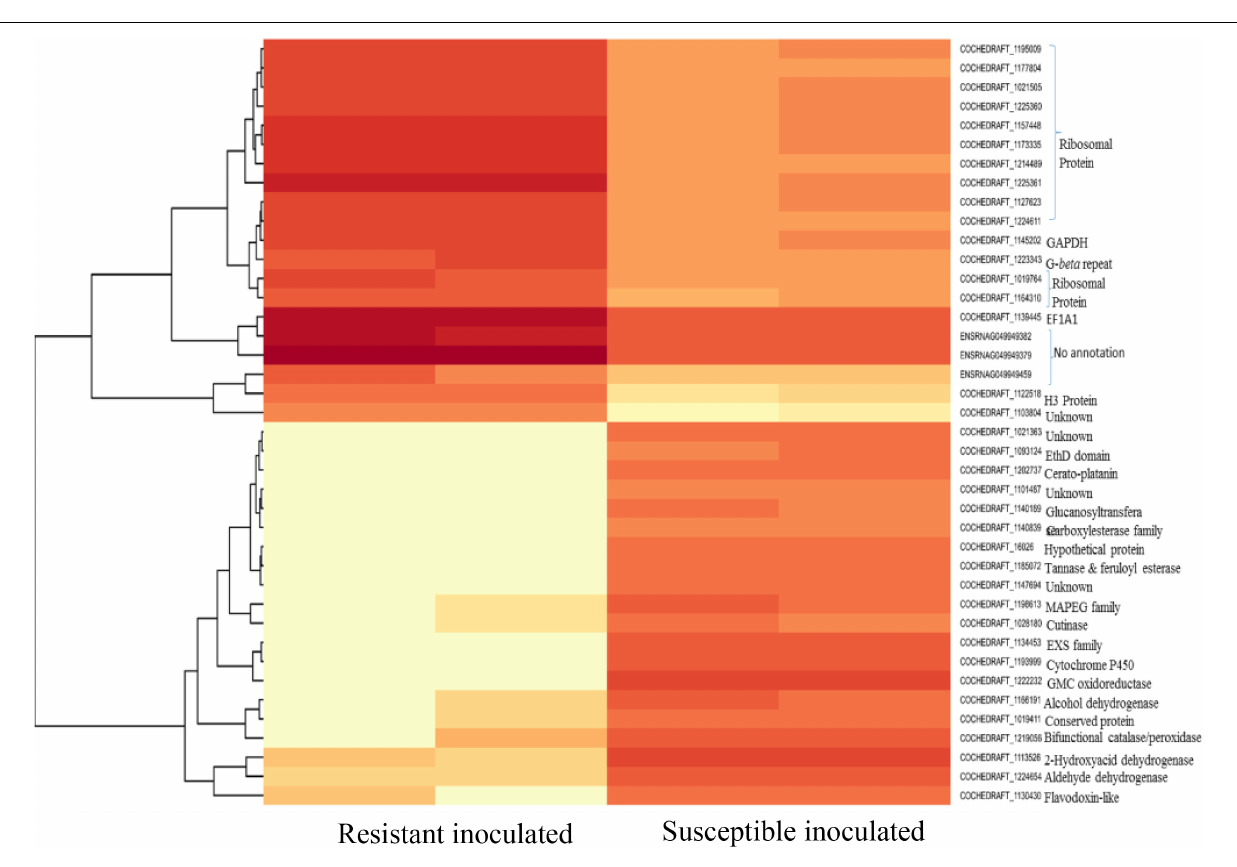
FIGURE 8 | Heat map of top 40 differentially expressed genes of B. maydis in resistant and susceptible maize genotypes 48 h post